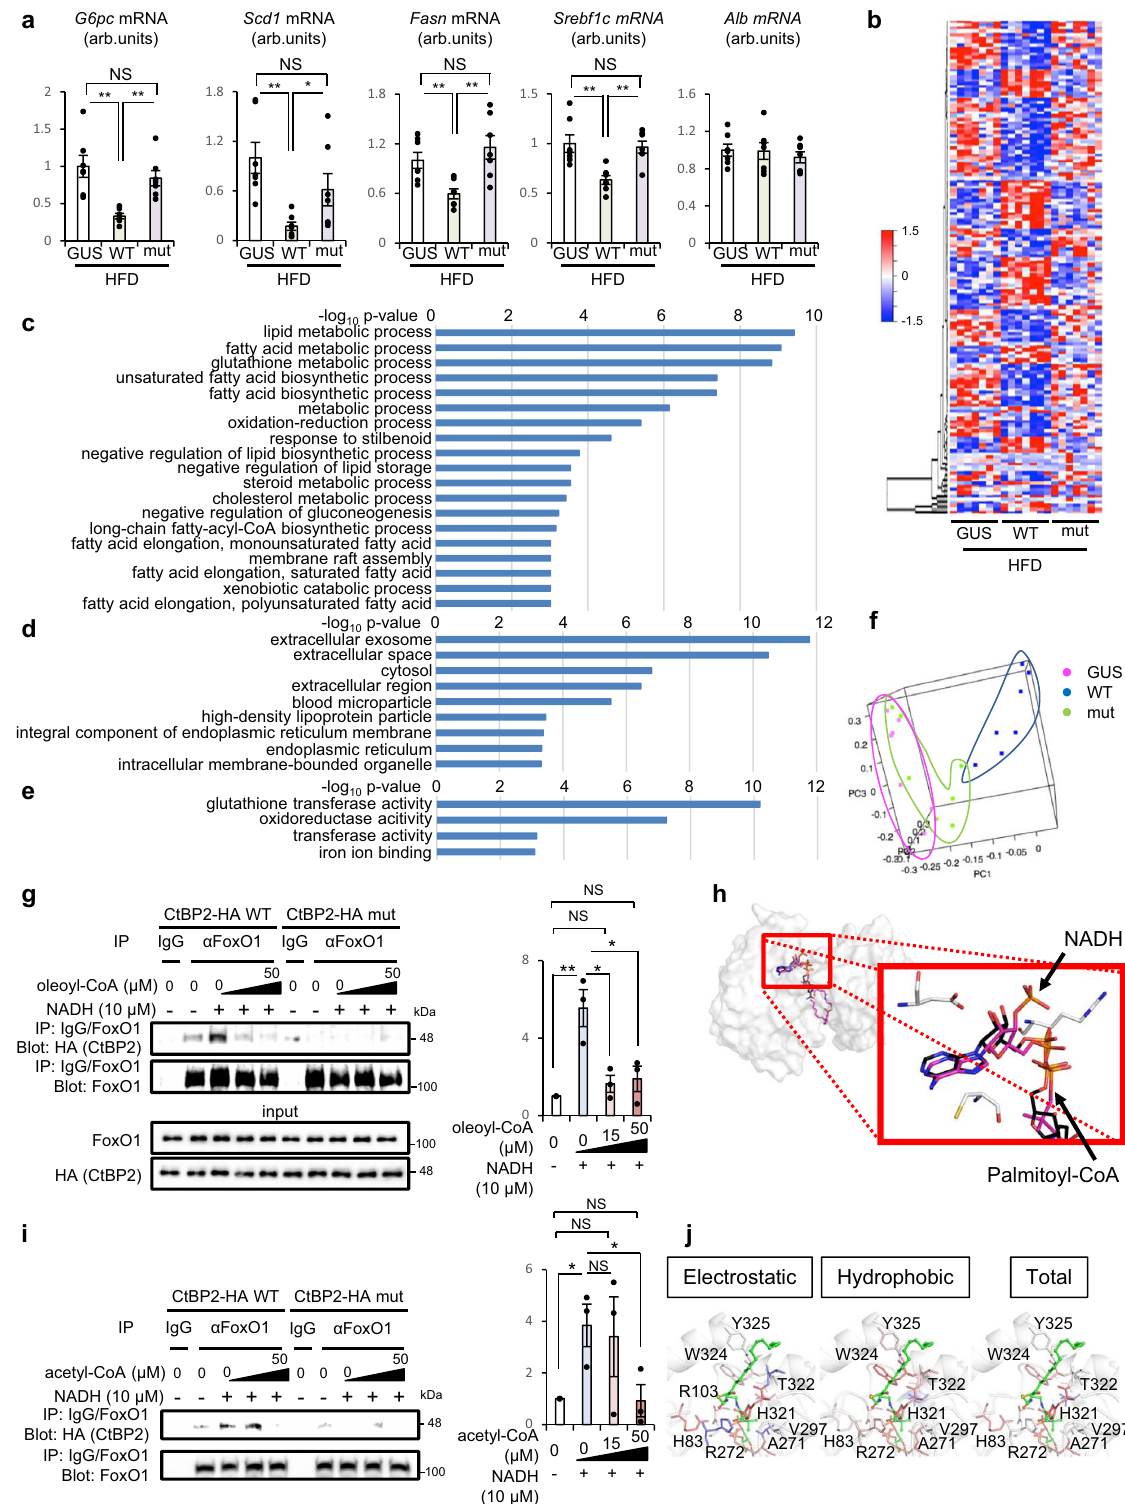
lipid metabolic process fatty acid metabolic process glutathione metabolic process unsaturated fatty acid biosynthetic process fatty acid biosynthetic process metabolic process oxidation-reduction process response to stilbenoid negative regulation of lipid biosynthetic process negative regulation of lipid storage steroid metabolic process cholesterol metabolic process negative regulation of gluconeogenesis long-chain fatty-acyl-CoA biosynthetic process fatty acid elongation, monounsaturated fatty acid membrane raft assembly fatty acid elongation, saturated fatty acid xenobiotic catabolic process fatty acid elongation, polyunsaturated fatty acid extracellular exosome extracellular space cytosol extracellular region blood microparticle high-density lipoprotein